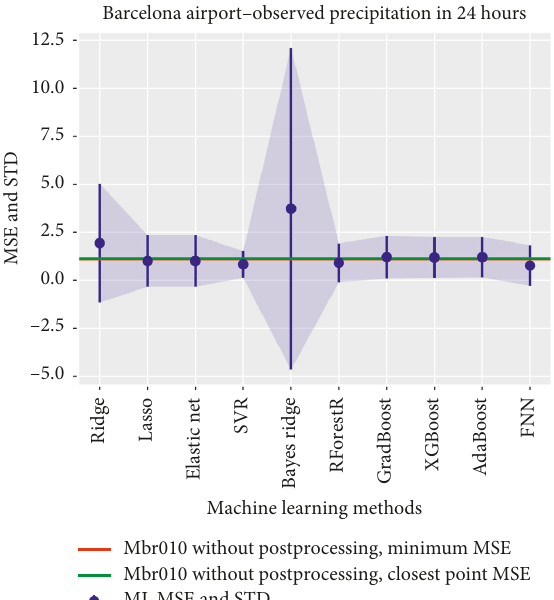
Figure 24: Precipitation in 24hours, standardized calibration plot for Barcelona airport. Horizontal axis as in Figure 18.